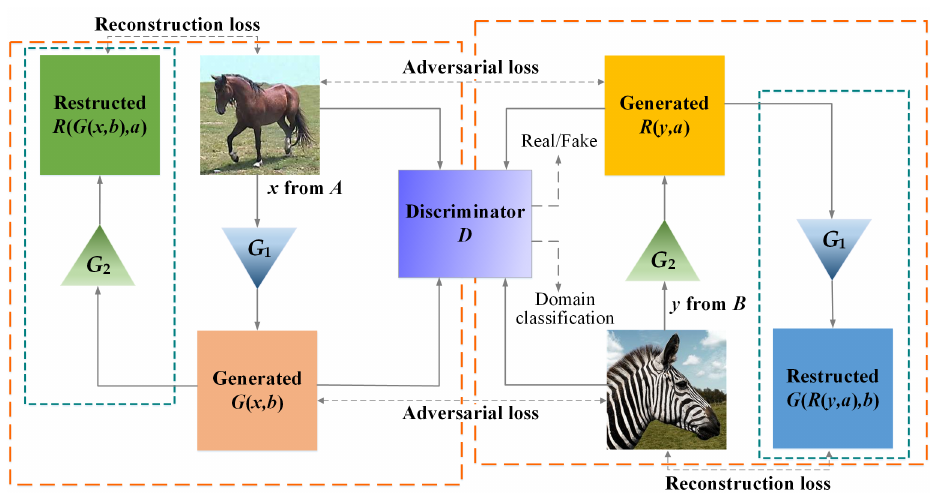
Figure 1. MRGAN contains two generators for transferring two styles of images each other. Generator G 1 is used for learning an mapping from domain A to domain B . Similarly, Generator G 2 is used for learning an mapping from domain B to domain A . The discriminator aims to distinguish generated images from real images of two domains.